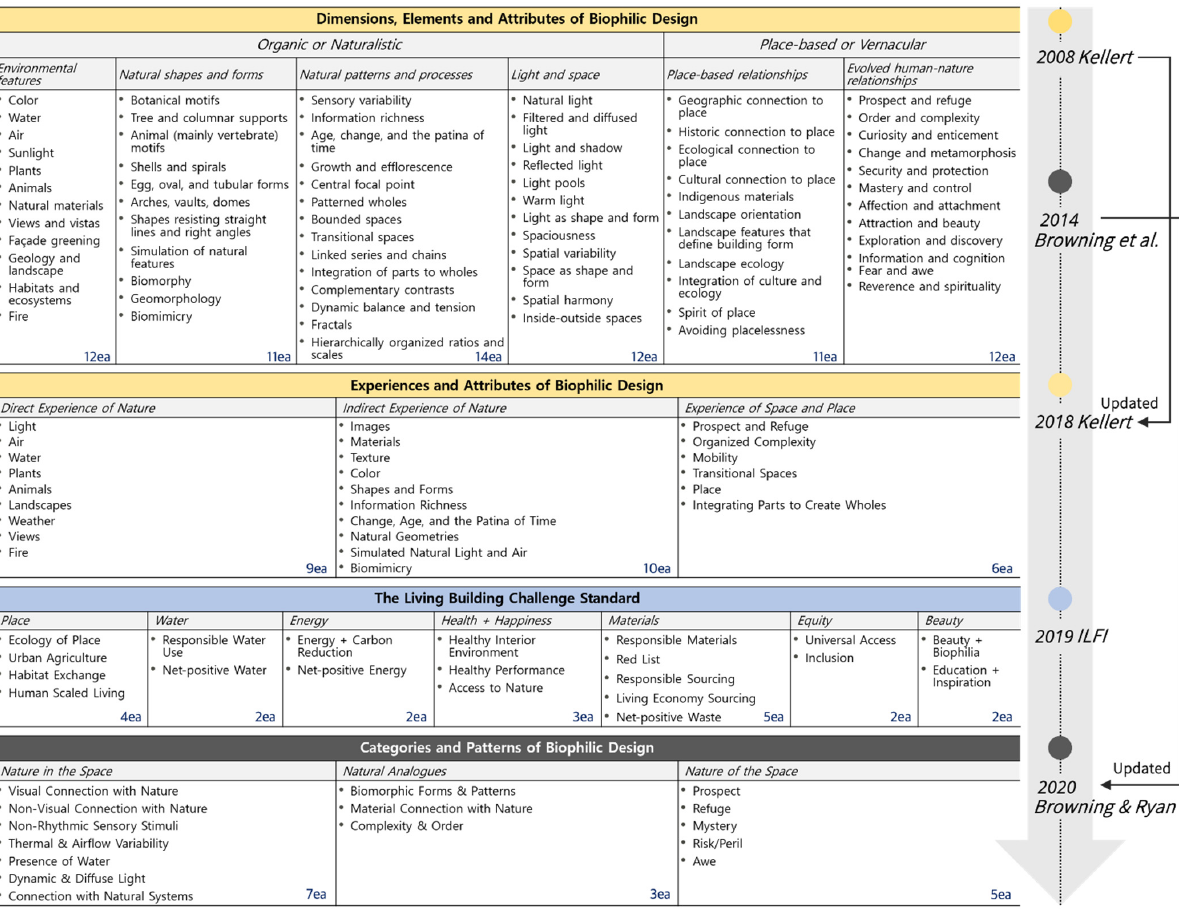
Figure 4. Main theoretical frameworks of biophilic design